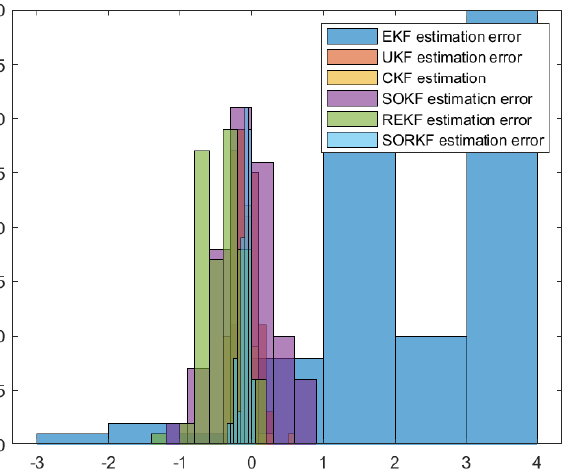
Figure 10. Histogram of R3 positioning estimation error in fixed